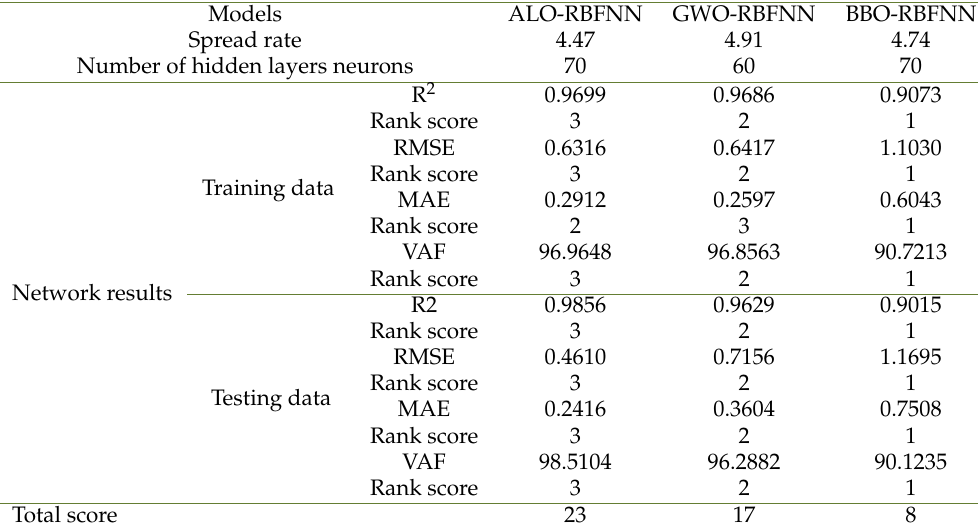
Table 2. Obtained values of performance evaluators for developed models